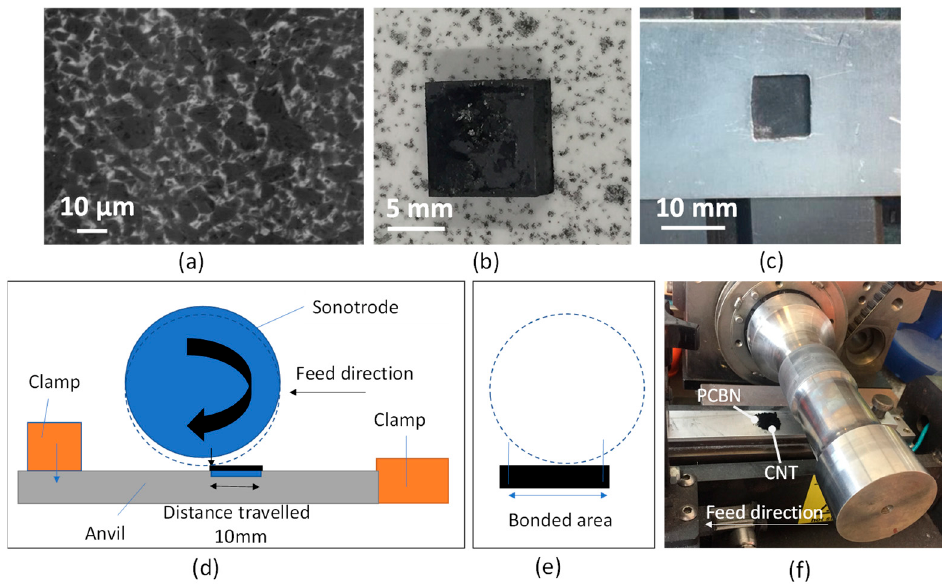
Figure 1. ( a ) Scanning electron microscope (SEM) micrograph of polycrystalline cubic boron nitride (PcBN) prior to coating, ( b ) PcBN square solid specimen for coating, and ( c ) tool-holder, ( d ) ultrasonic machine schematic, ( e ) area of bonding in cross-section, and ( f ) joining apparatus.